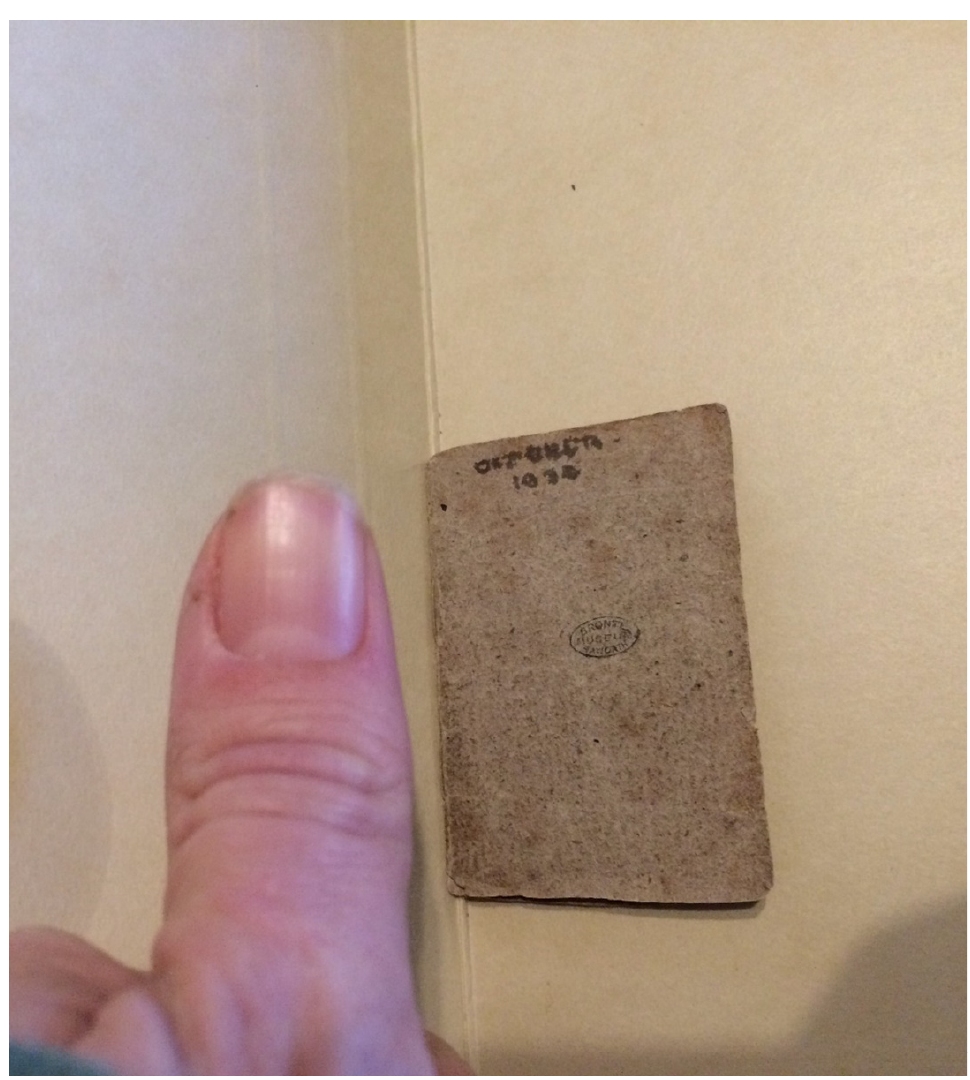
Figure 1. The author’s thumb next to an early edition of the Young Men’s Magazine. Images are the author’s photos taken with kind permission from The Bronte except as otherwise indicated.